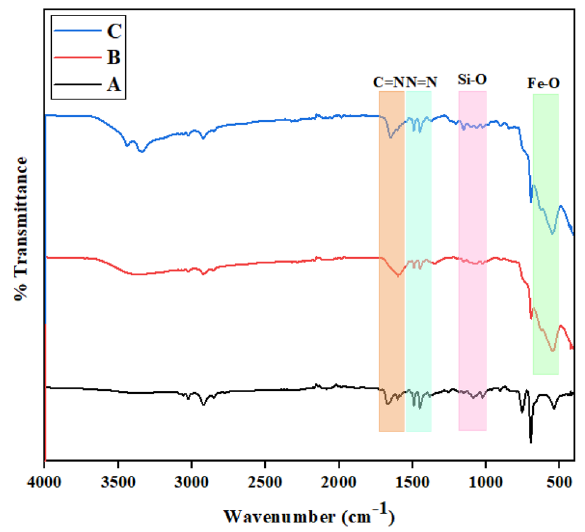
Figure 2. FT ‐ IR spectra of Ps@Tet ( A ), Ps@Tet@Fe 3 O 4 ( B ) and Ps@Tet-Cu(II)@Fe 3 O 4 ( C ).